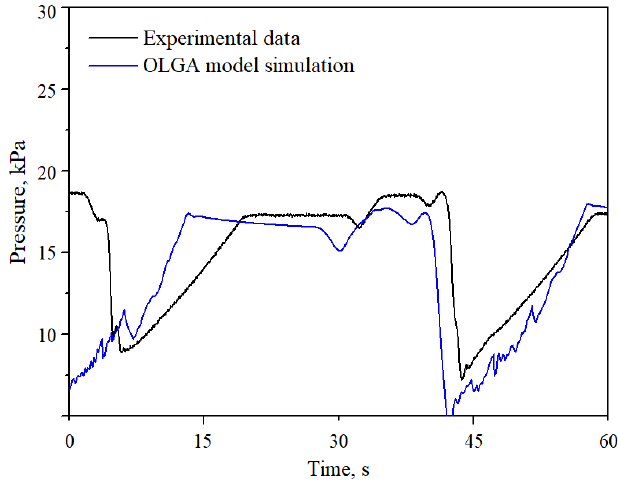
Figure 12. Measured and simulated riser-base pressure profiles of severe slugging ( U GS = 0.08 m/s and U LS = 0.09 m/s).